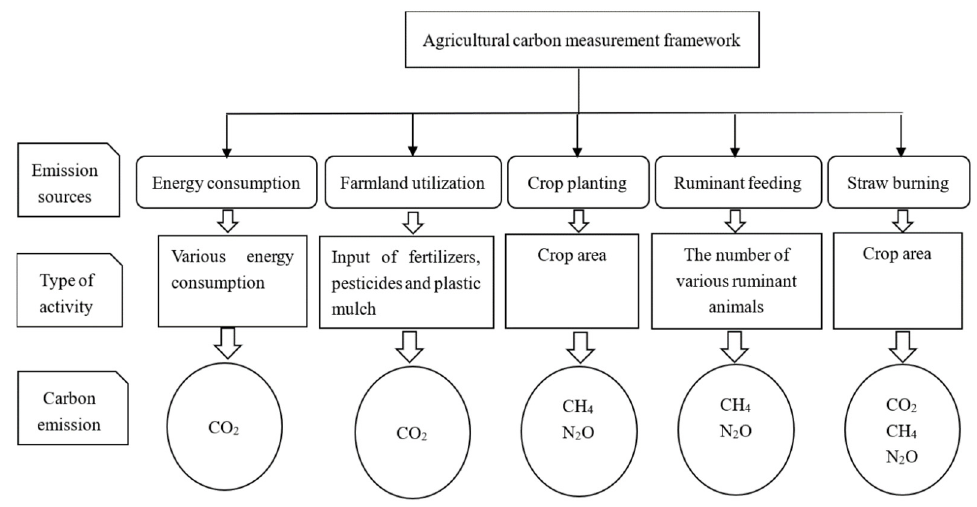
Figure 2. Agricultural carbon emission measurement framework.